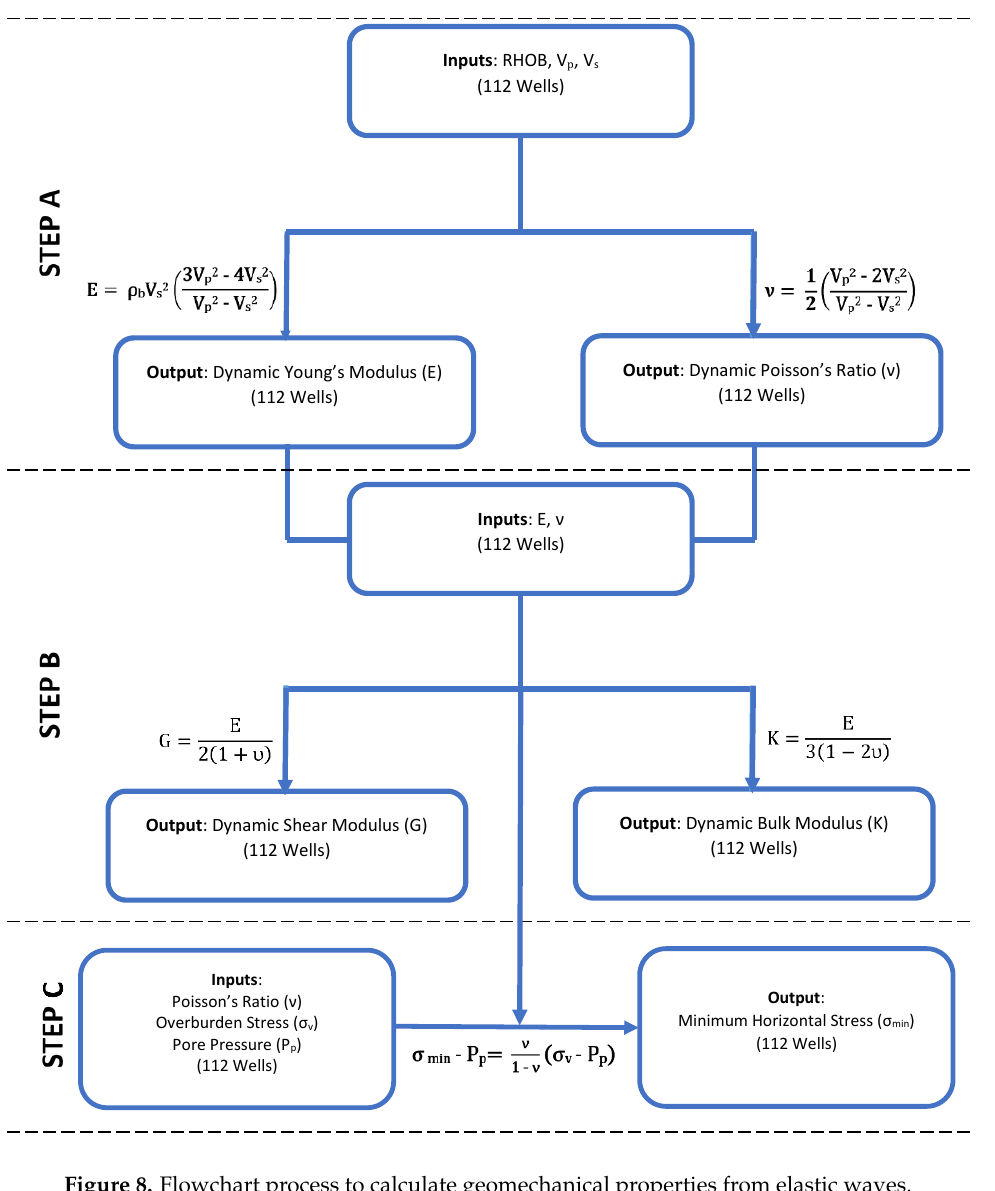
Figure 8. Flowchart process to calculate geomechanical properties from elastic waves.